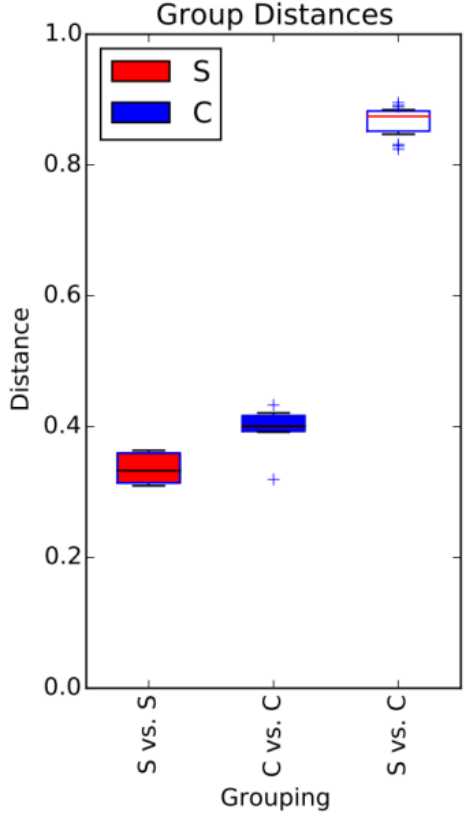
Figure 4. Box-whisker plot for the group distances.